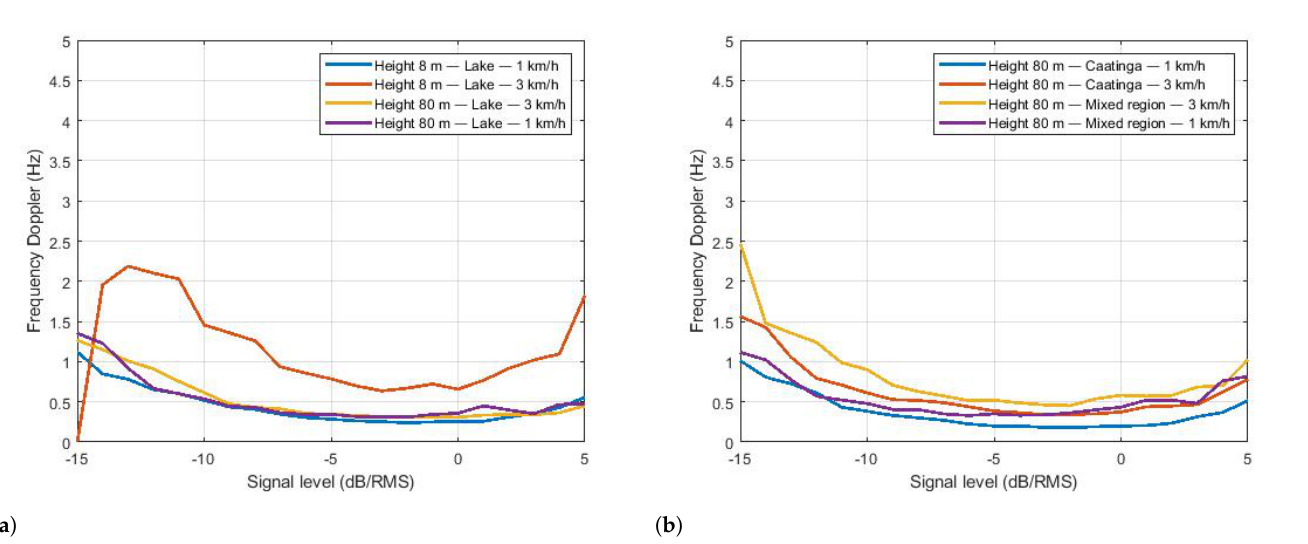
Figure 12. Doppler frequency estimation. ( a ) Doppler frequency for Lake region. ( b ) Doppler frequency for Caatinga and Mixed regions. Table 9. Maximum and minimum variation of theoretical Doppler scattering.